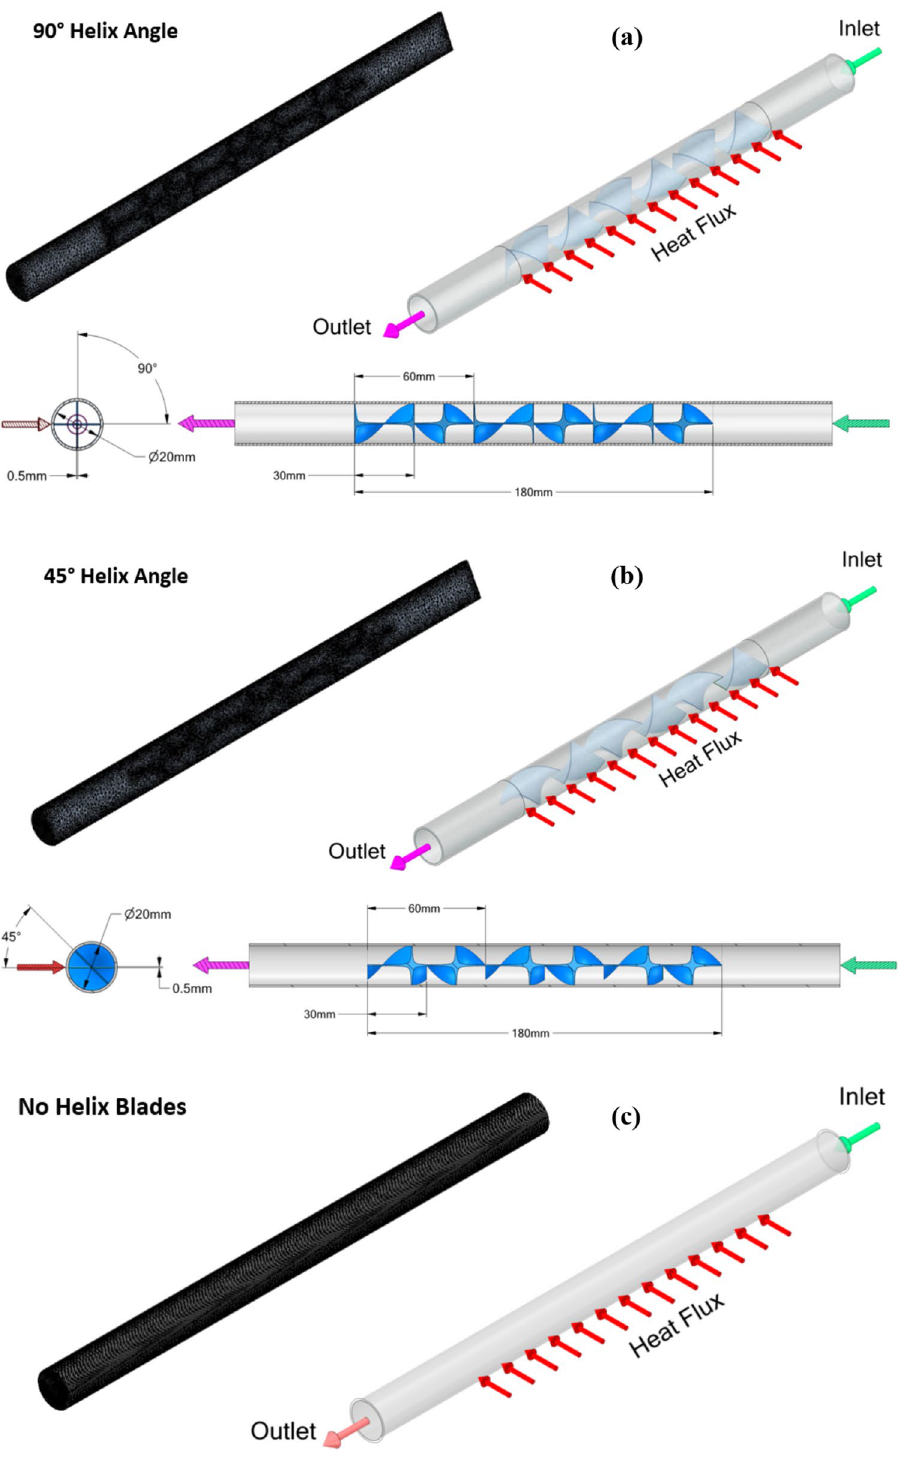
Figure 1. Schematic diagram of p physical and computational domain; ( a ) 90° helix angle, ( b ) 45° helix angle, ( c ) no helix